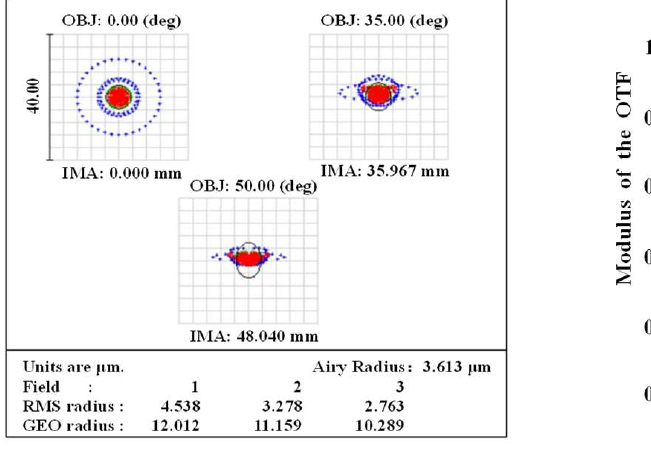
Figure 8. Ray fan plot of the field angle 0° ( a ), 35° ( b ), 50° ( c ), respectively.